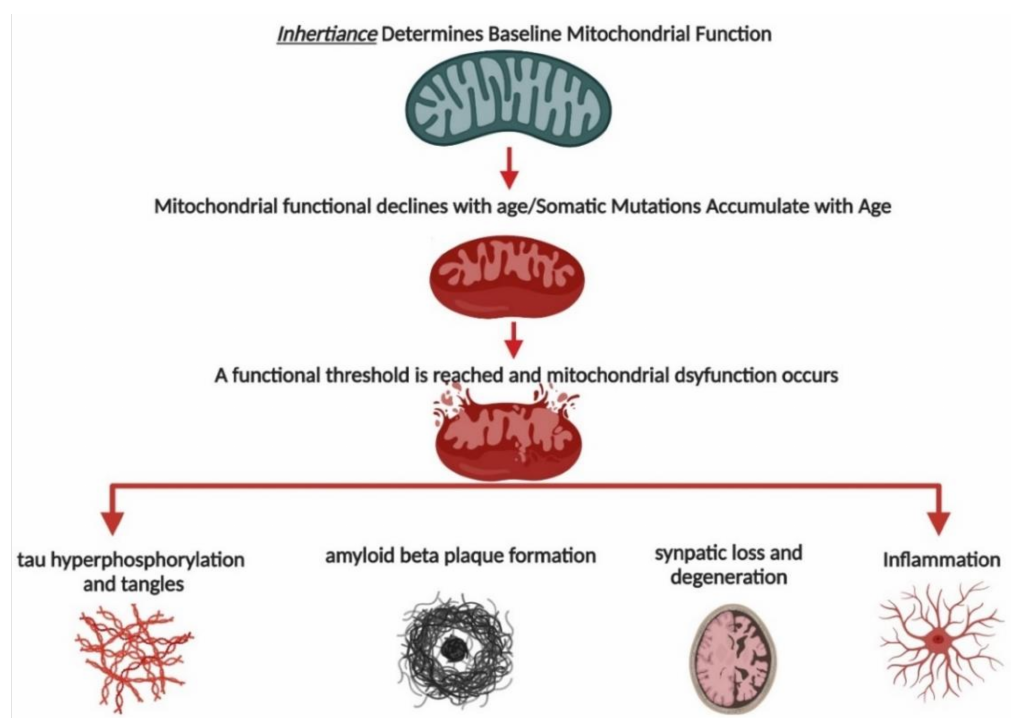
Figure 1. Mitochondrial-Cascade Hypothesis of AD. Inherited mtDNA determines baseline function for individuals. During aging, mitochondrial function declines and somatic mutations accumulate. If baseline function is low, mitochondrial dysfunction occurs earlier than if baseline function is high. Eventually, a functional threshold is reached where mitochondrial dysfunction leads to a cascade of loss of proteostasis (A β plaques, tau tangles), inflammation, and neuronal loss/degeneration.